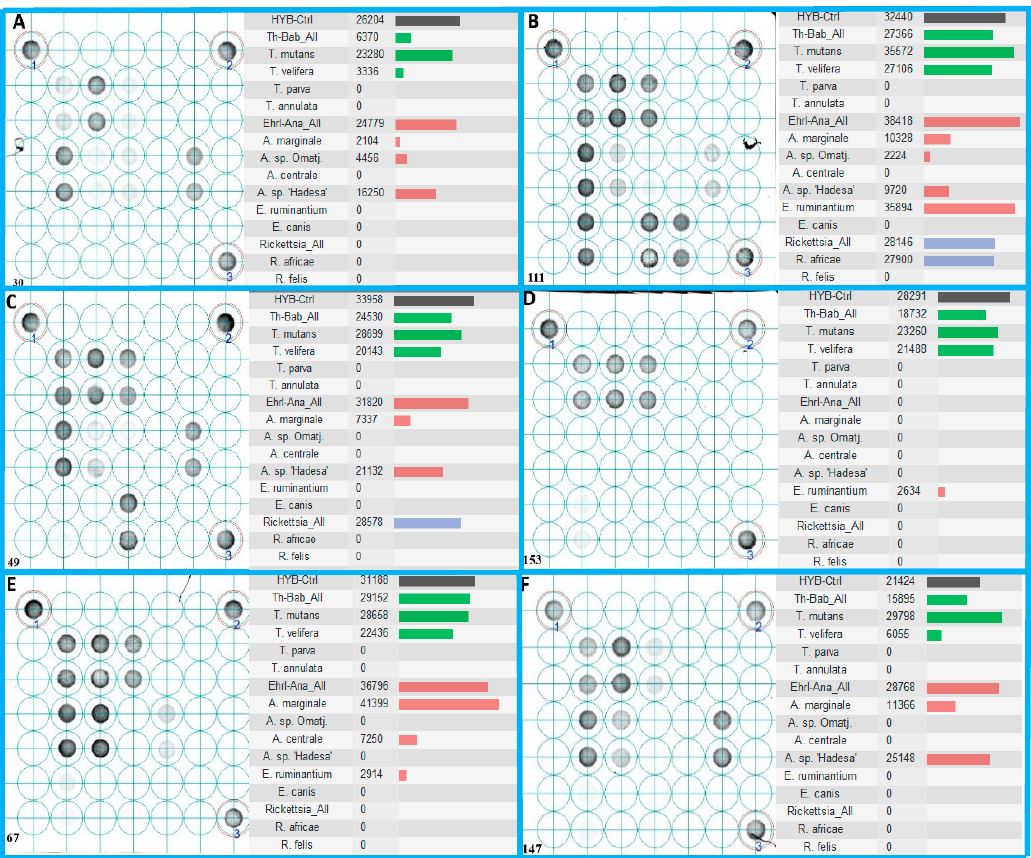
Figure 4. Probe hybridization of six field-collected blood samples ( A – F ) on LCD-Array detecting tick-borne pathogens, with 1–3 representing the proprietary kit controls. All shown specimens exhibit co-infections with a minimum of three tick-borne pathogens. The right half of each delimited box shows the hybridization intensity of the corresponding target probe duplicates (Kit control: Black color bar; Babesia / Theileria : green color bar; Anaplasma / Ehrlichia : red color bar; Rickettsia : blue color bar). Results below the cut off value of 2000 are considered negative.